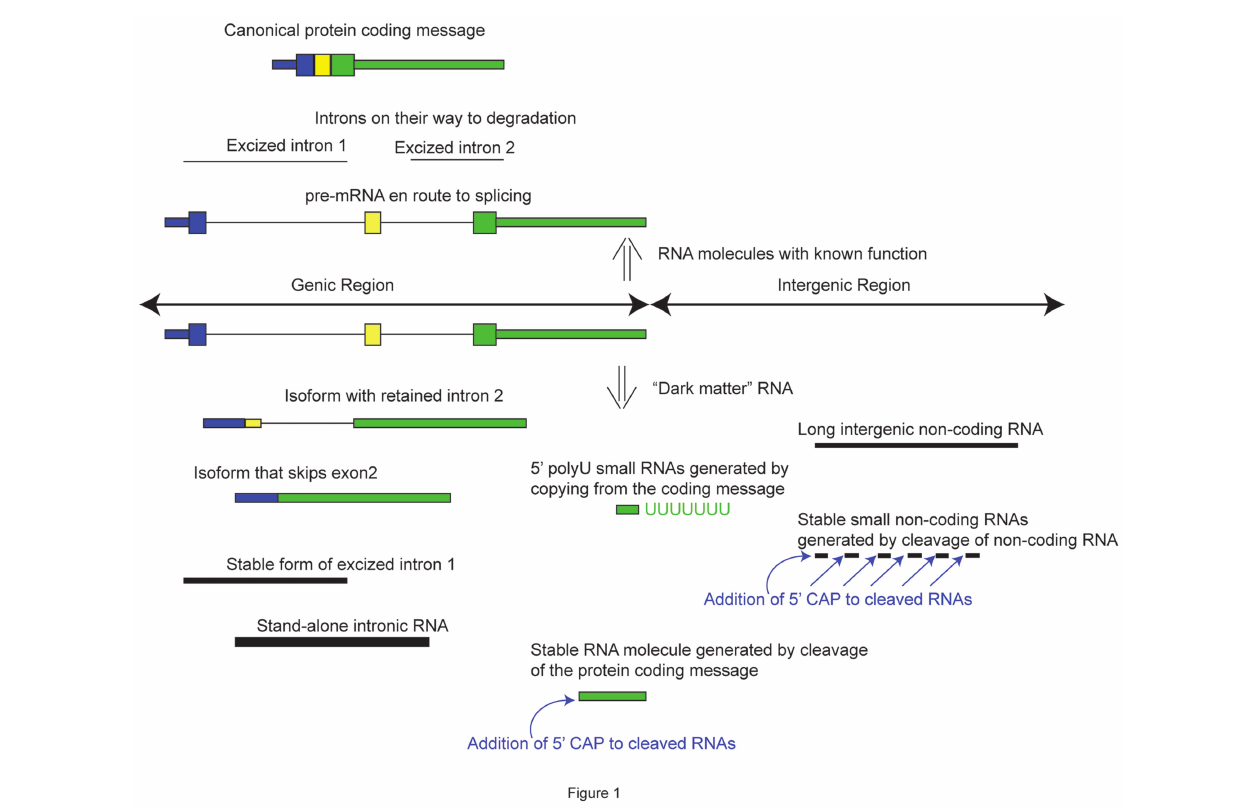
FIGURE 1 |Types of RNA molecules derived from annotated and unannotated loci that constitute “dark matter”